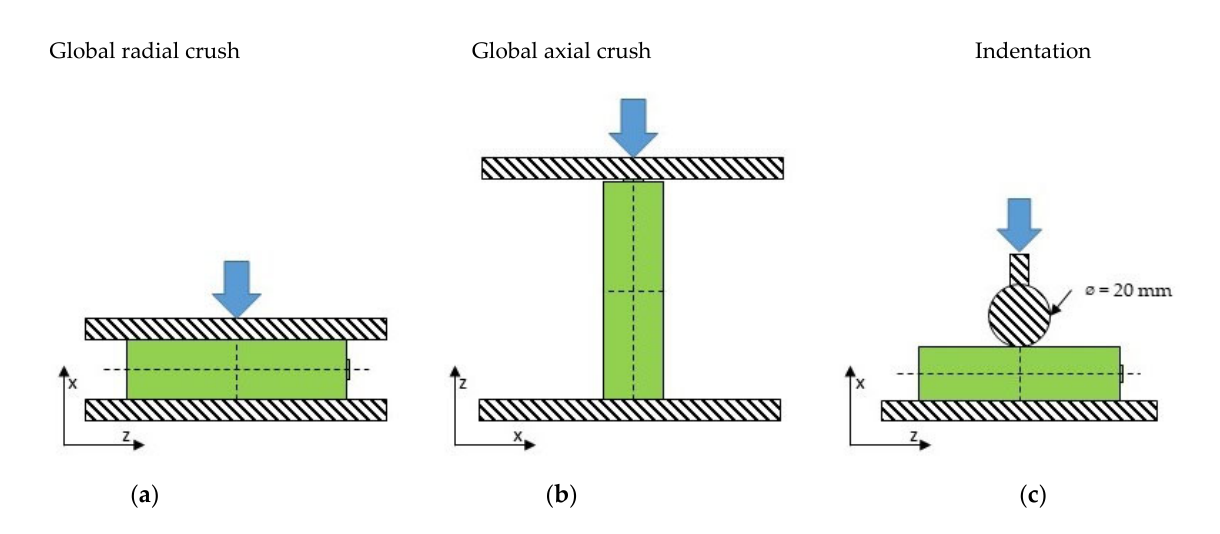
Figure 4. Mechanical load configurations for data acquisition: ( a ) global radial crush, ( b ) global axial crush and ( c ) indentation. The blue arrow indicates the acting force.